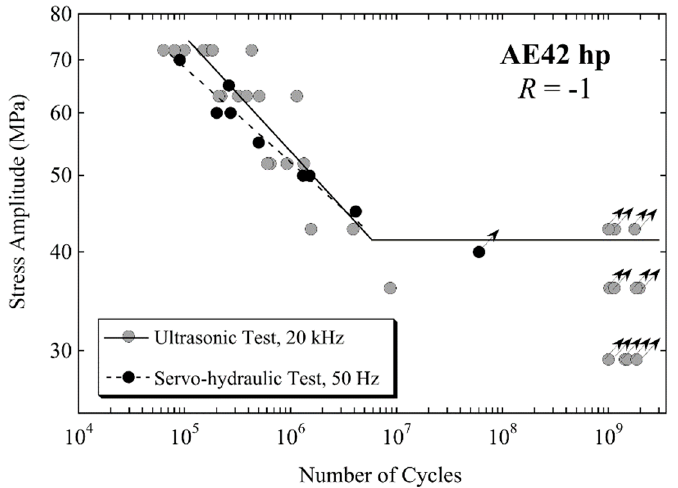
Figure 15. Fatigue data of magnesium alloy AE42 hp produced by high-pressure die-casting; data measured with servo-hydraulic (black circles) and ultrasonic equipment (grey circles) are shown; adapted with permission from Elsevier [18].